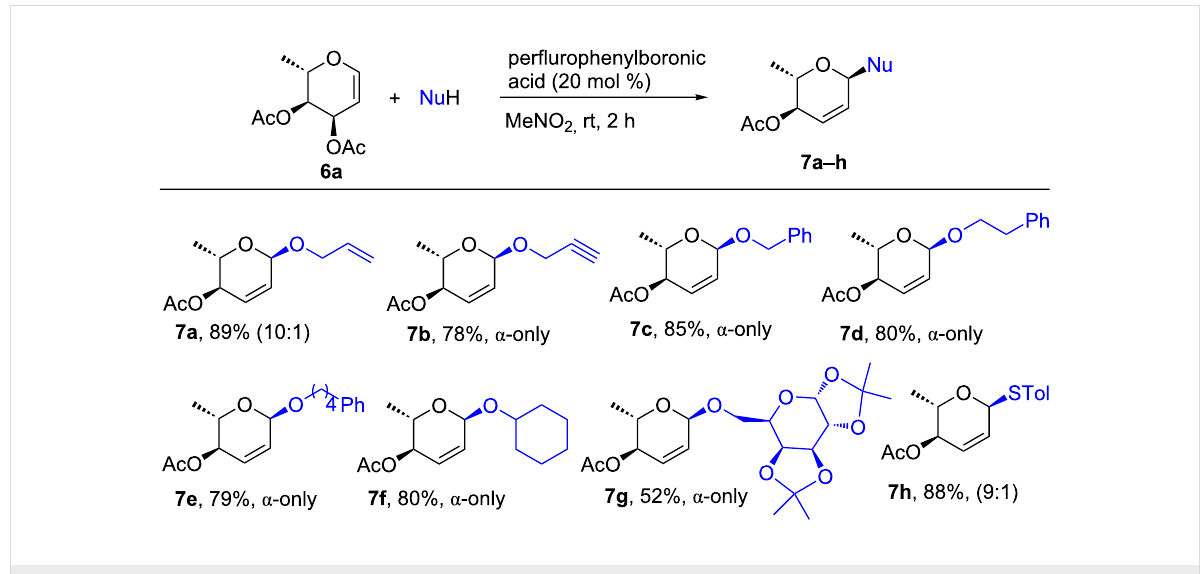
Figure 3: Perfluorophenylboronic-acid-catalyzed reaction between 3,4-di- O -acetyl-L-rhamnal ( 6a ) and O- and S -nucleophiles.